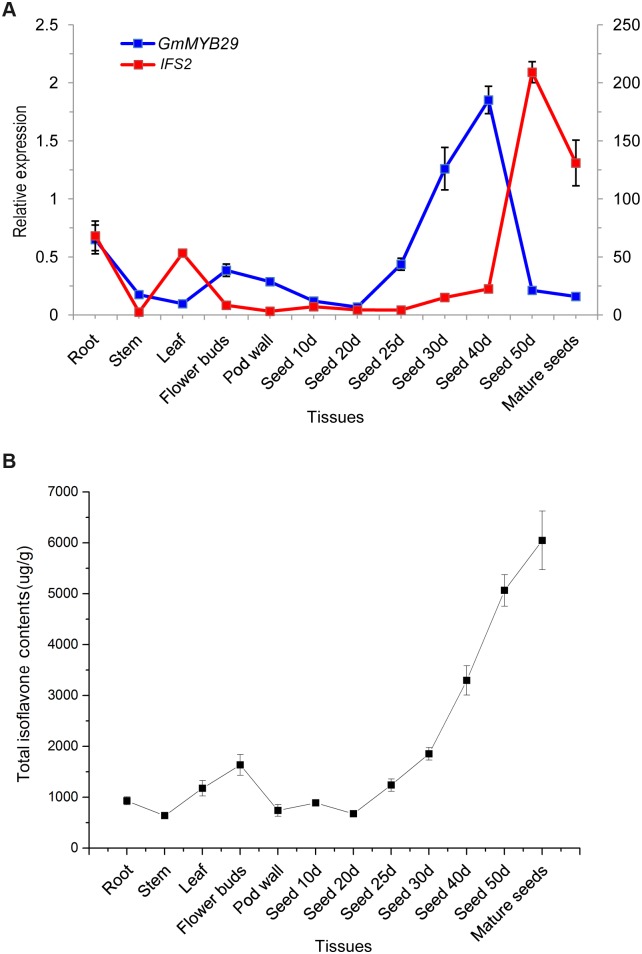
Expression of GmMYB29 and IFS2 and total isoflavone contents in different soybean tissues.(A) Expression of GmMYB29 and IFS2 in different soybean tissues. Bars represent the standard errors of three technical replicates for two biological replicates. (B) Accumulation pattern of total isoflavones in different soybean tissues. Bars represent the standard errors of three technical replicates for two biological replicates.